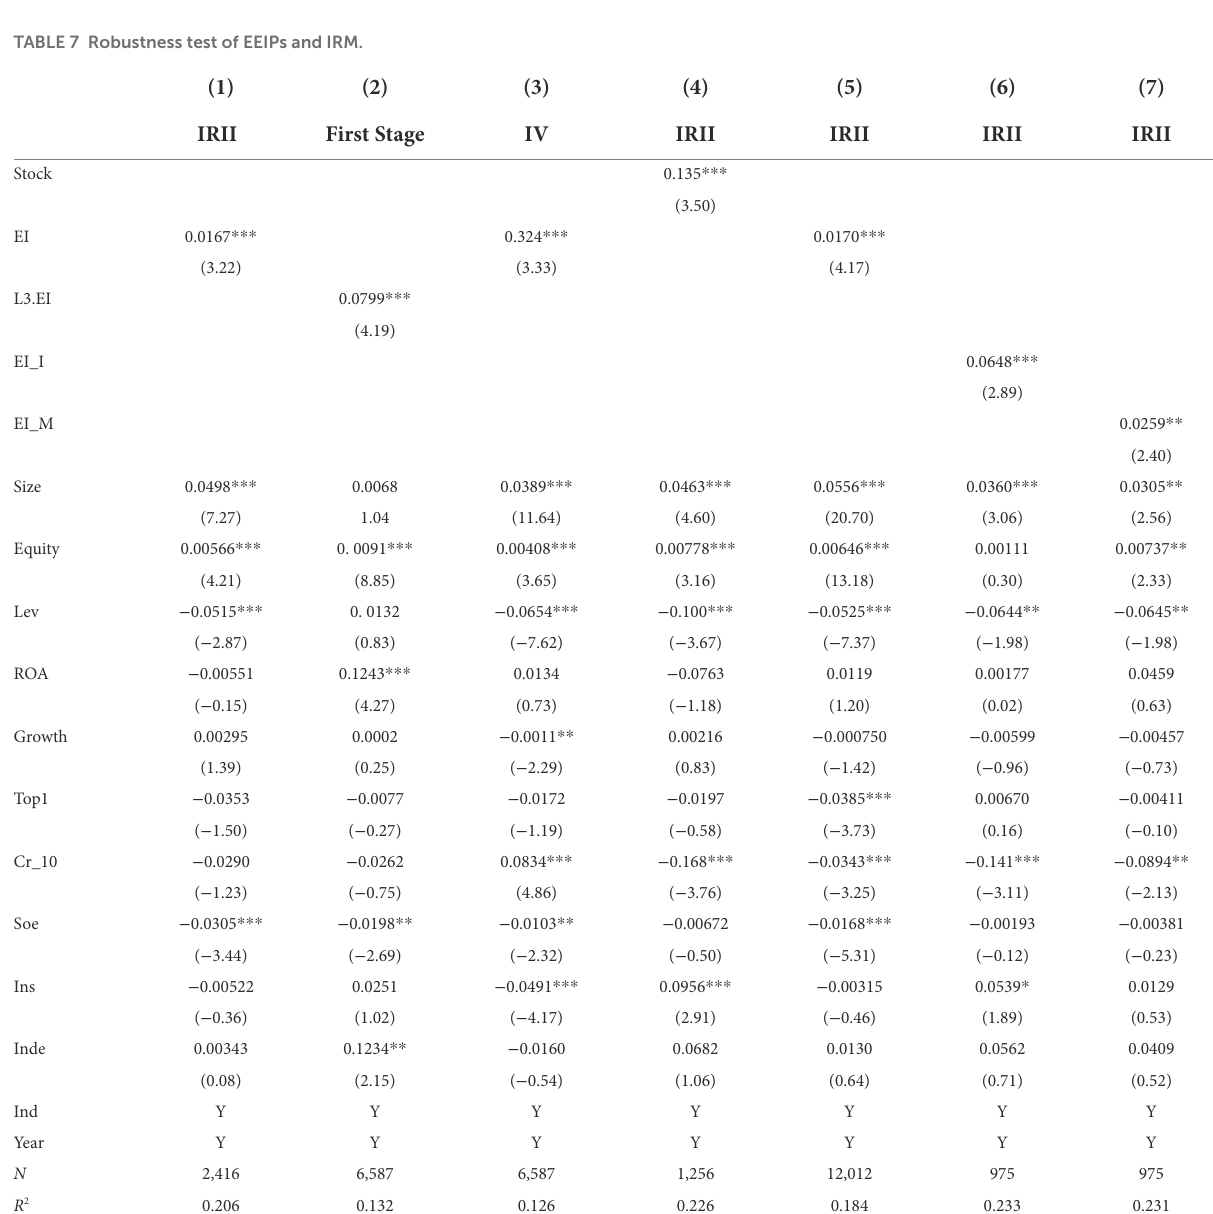
TABLE 7 Robustness test of EEIPs and